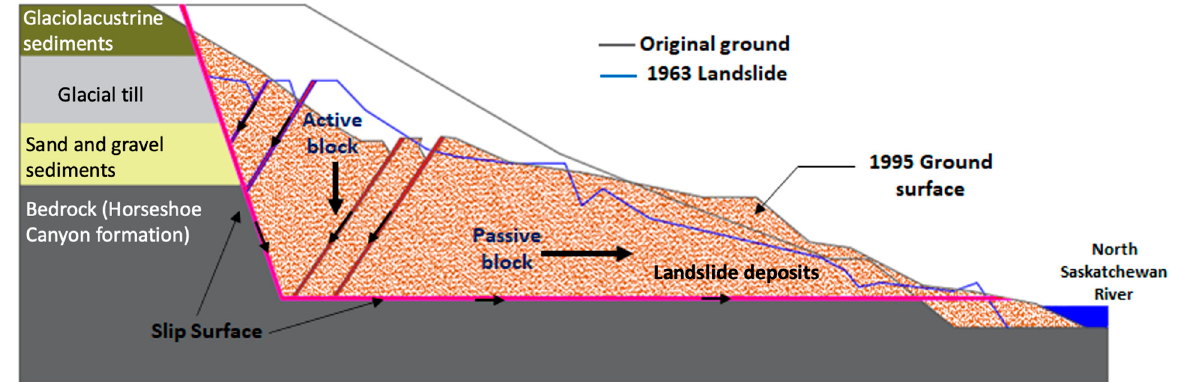
Figure 5. Lesueur landslide kinematics—adapted from [24] (not to scale).